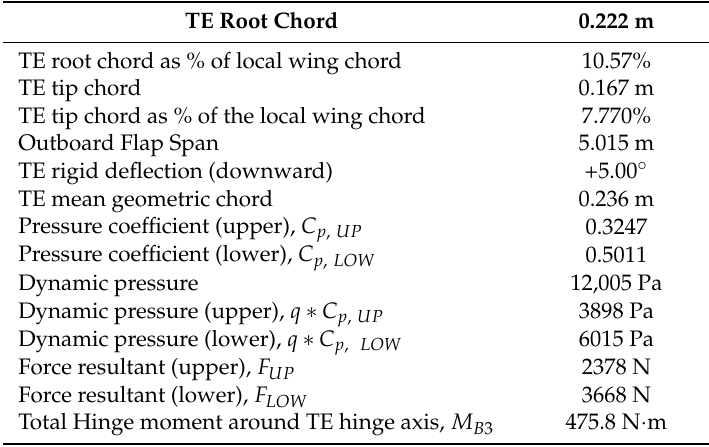
Table 1. Flap tab geometric data and Limit Load Condition considered for its design (loads obtained by means of DLM).